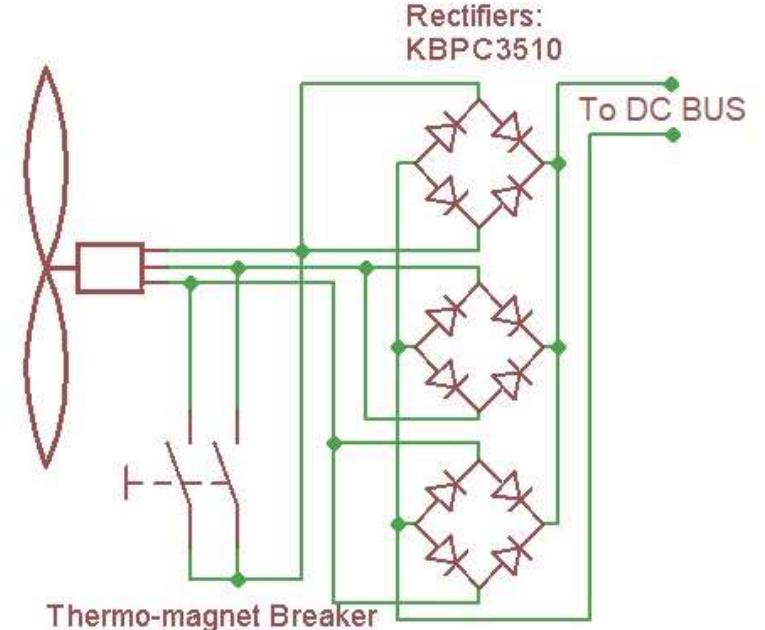
Figure 6. Power control scheme in the case study, including a rectifier and a crowbar (thermo-magnet breaker).